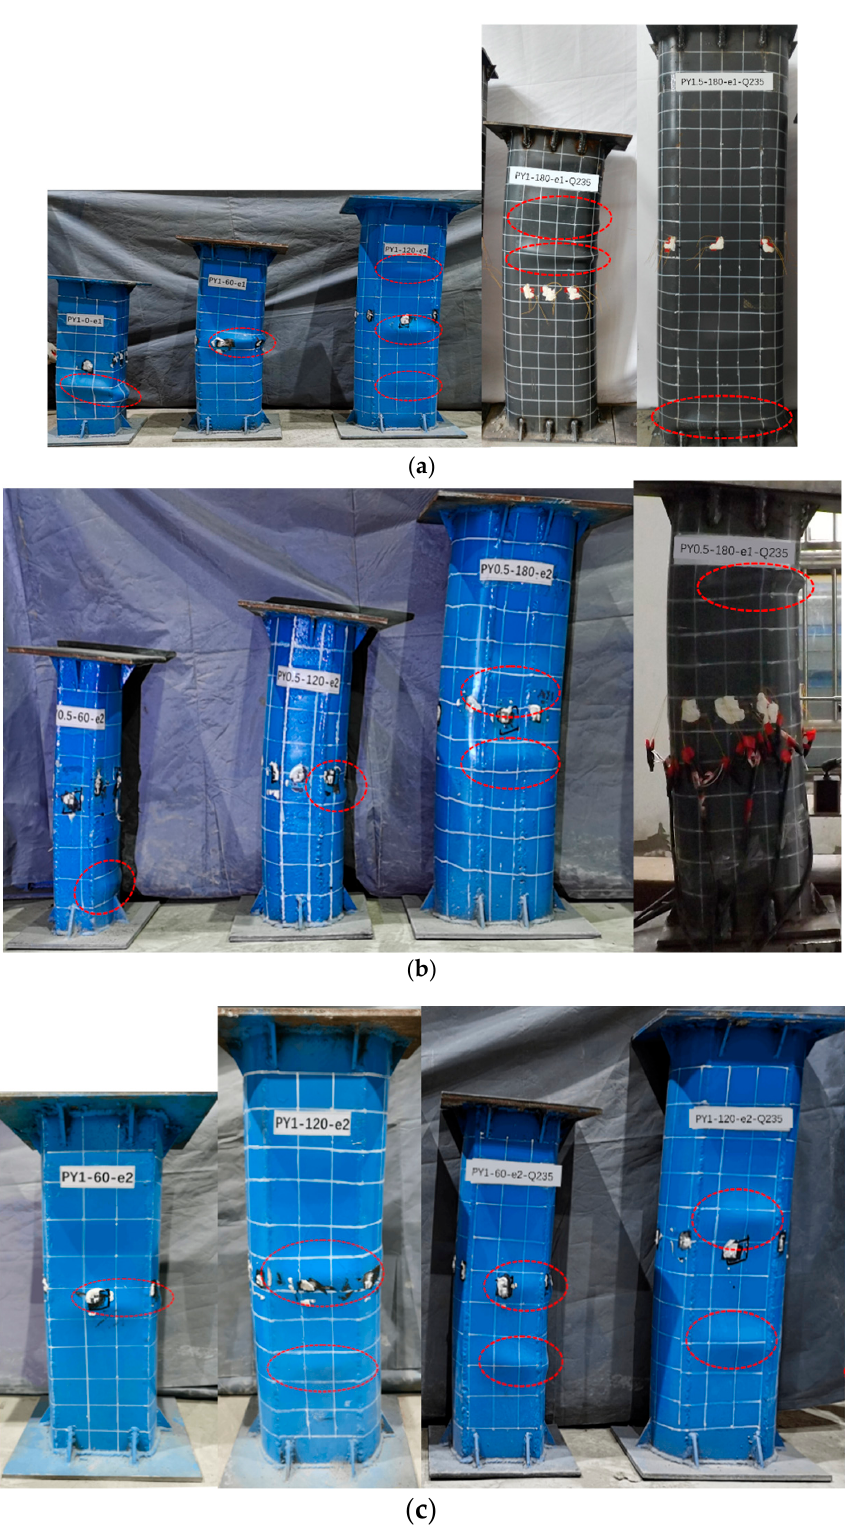
Figure 7. Failure modes: ( a ) κ = 1 and 1.5, with different θ and f y ; ( b ) κ = 0.5, with different θ and eccentric ratio; ( c ) Different f y .